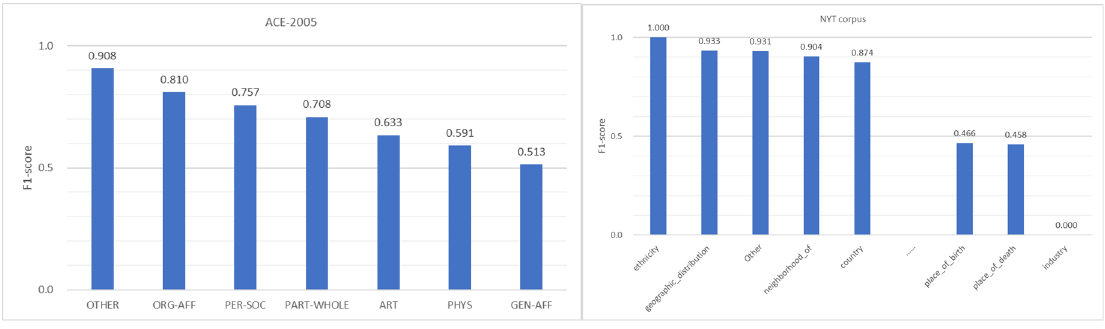
Figure 5. Performances per relation type.